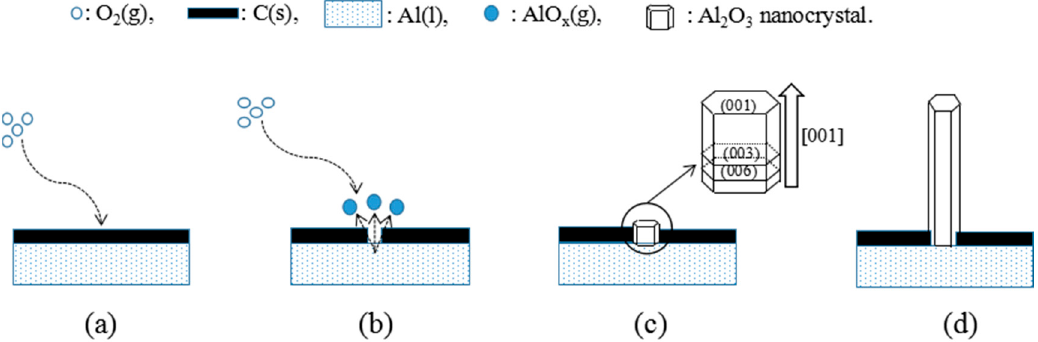
Figure 7. The generation mechanism of Al 2 O 3 whiskers: ( a ) deposition of O 2 on molten Al layer; ( b ) generation of AlO x (g); ( c ) growth on the direction of [001] and ( d ) the formation of Al 2 O 3 whiskers.